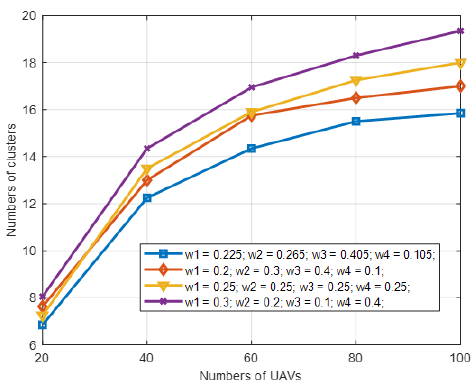
Figure 7. Number of clusters in different weight settings with varying numbers of UAV nodes in IWLC scheme.